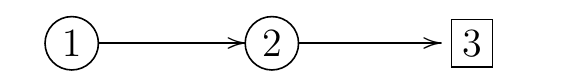
Figure 3: The non-Abelian gauged linear sigma model description of the flag mani- fold SU ( 3 ) / U ( 1 ) 2 . It is related to the Abelian quiver in Figure 2 by a duality move on the middle